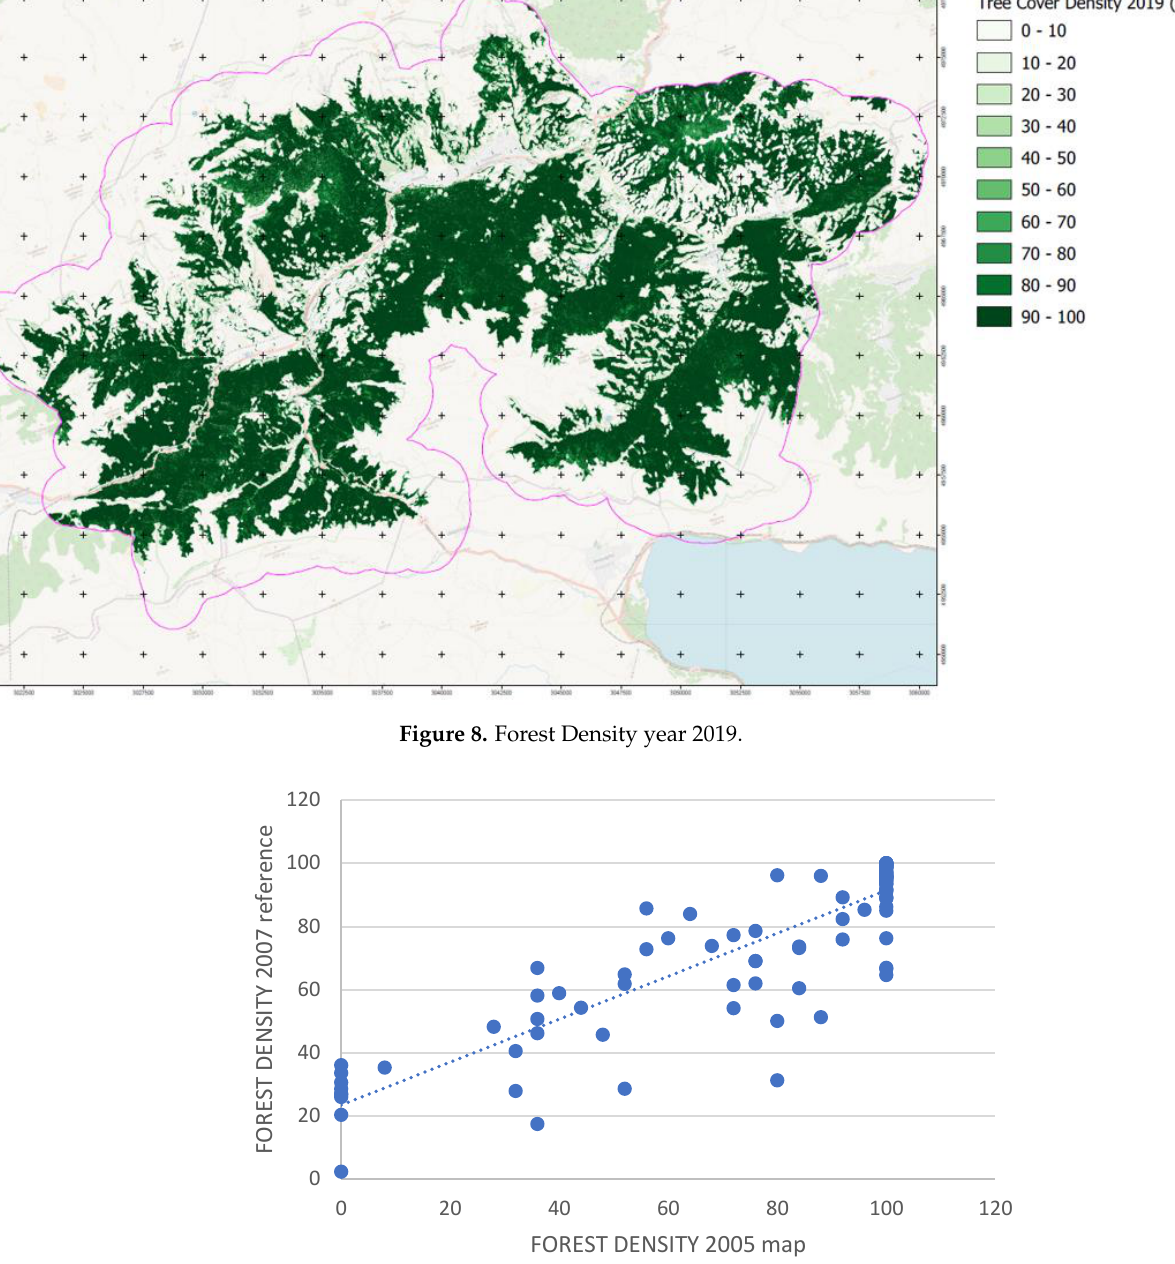
Figure 9. Correlation between Forest Density 2007 reference (computed from interpretation of SSUs) and Forest Density 2005 map values (R 2 = 0.7756) .